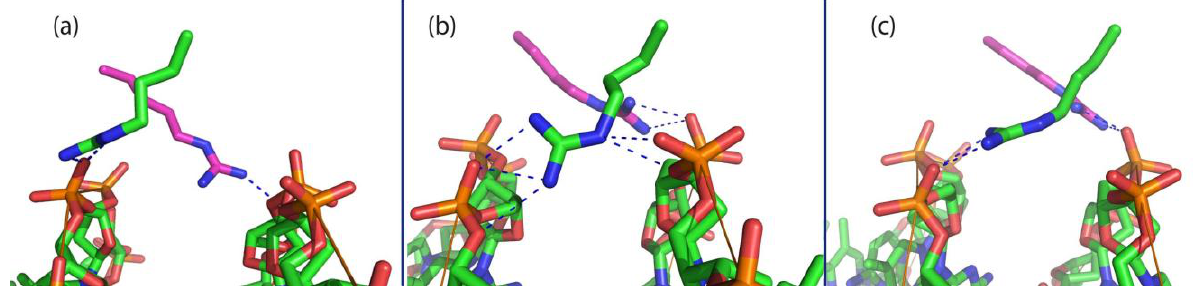
Figure 3. Selected images of Arg 54 rearrangement at ( a ) 0 ns, ( b ) 2.4 ns and ( c ) 4 ns. Arginine 54 -monomer B (violet) interacts only with T + 2 phosphate along the trajectory. Arginine 54 -monomer A (green) interacts with G − 1 phosphate in ( a ); with G − 1 and T + 3 phosphates and with deoxyribose O3 atoms of A0 and T + 3 in ( b ) and with G − 1 phosphate in ( c